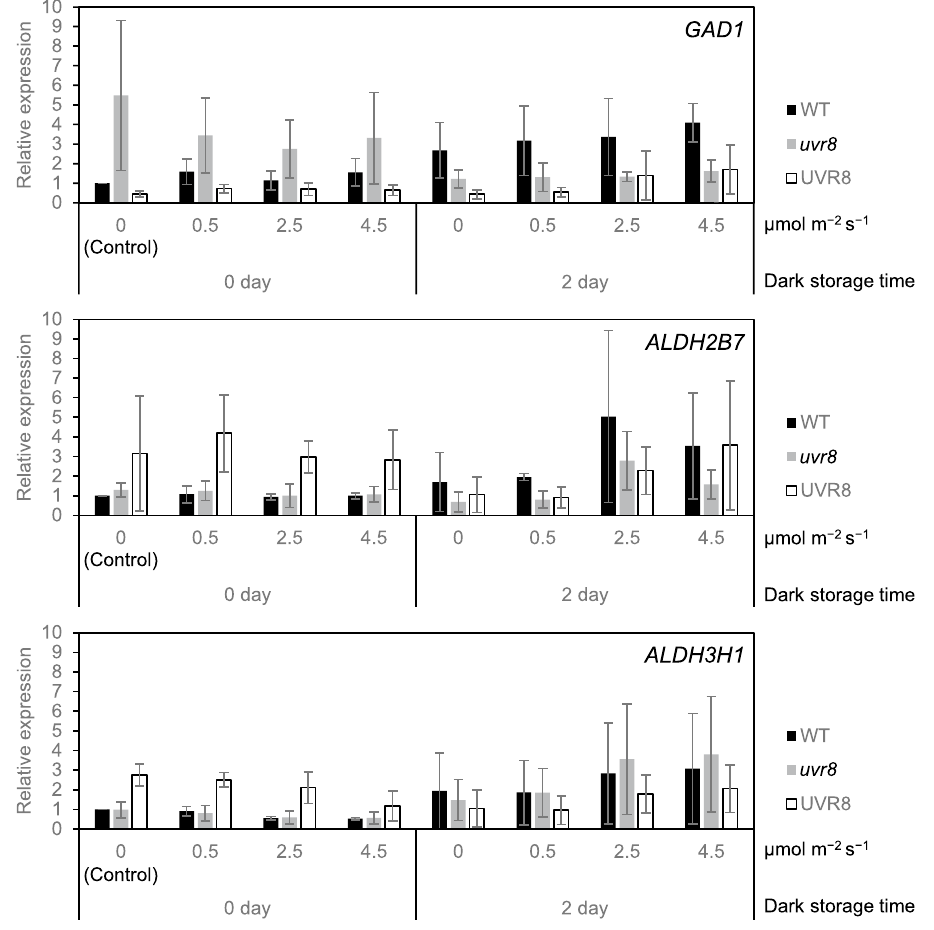
Figure 8. Effect of 280 nm UV-LED irradiation of Arabidopsis plants at different dose on expression of genes involved in GABA metabolism. Fourteen-day-old Arabidopsis plants were used for RT-qPCR analysis. The expression of genes involved in GABA metabolism in Arabidopsis plants irradiated by 280 nm UV-LED at 0.5, 2.5, and 4.5 µmol m −2 s −1 was analyzed by RT-qPCR. Col-0 without irradiation and dark storage was used as a control to compare the expression levels. The data are presented as means of three biological replicates with error bars showing SDs. Welch’s t -test was applied to the comparison between the control and other samples, and no significant difference was observed ( P -value < 0.05). WT, wild type; UVR8 , UVR8 overexpression line 11–6; uvr8 , uvr8 mutant line